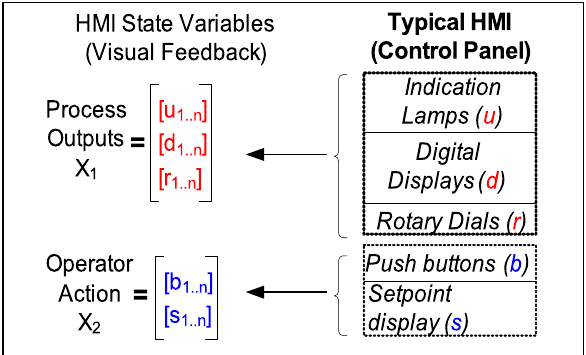
Figure 4. Conceptual data model for a typical industrial HMI (Control Panel), which is represented by two multidimensional feature vectors for Process outputs and Operator Action ( X 1 and X 2 ). Process output for each output devices, for example, Indication lamps, digital displays, rotary dials states or values, corresponding to particular dimensions of X 1 . Operator actions that are indicated by push button, hand switches or setpoint display states corresponding to particular dimensions of X 2